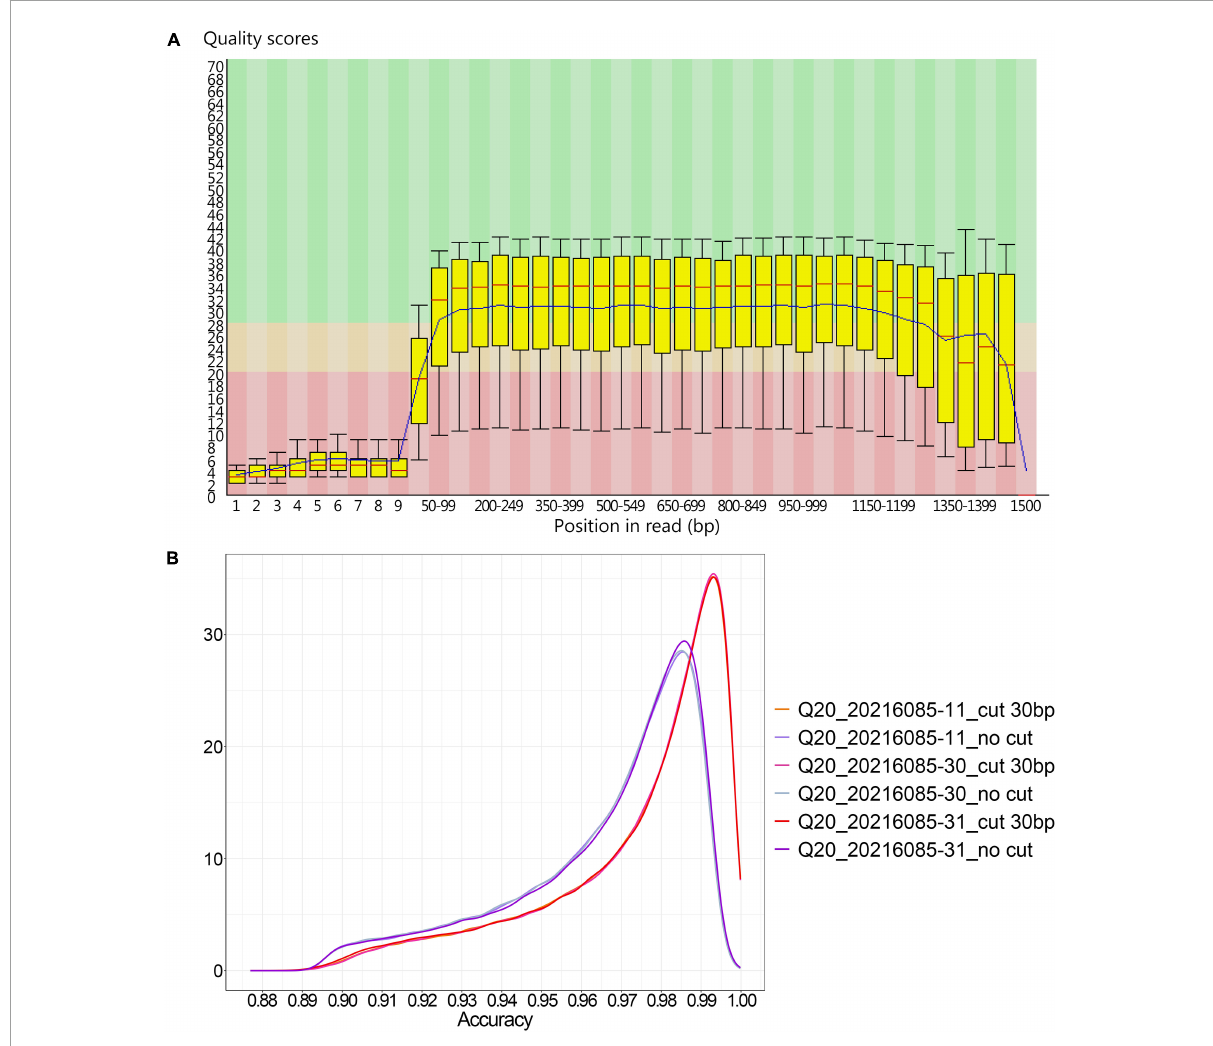
FIGURE2 The accuracy of 1200 bp amplicons sequenced by method A. (A) The single-base Q value corresponding to the base position in the 1200 bp amplified product from method A; (B) The density distribution of sequence accuracy of the 1200 bp amplified product with and without the 30 bp adapter sequence cut in method